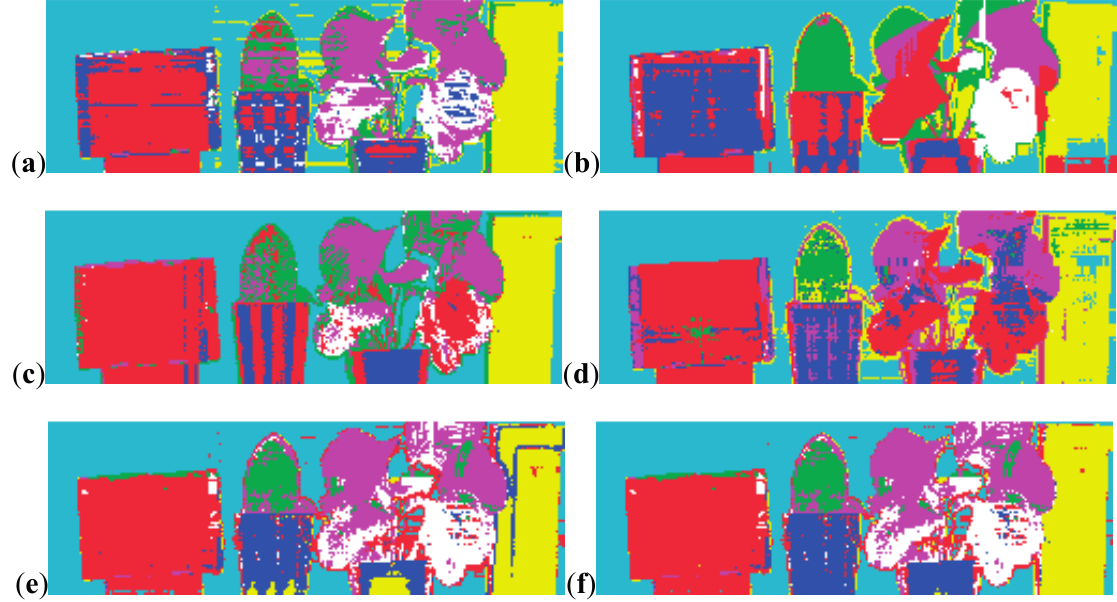
Figure 5. ( a ) Three-dimensional distribution of the scanned points in the scene; ( b ) Interpolated gray image with pixel values representing the distance information; ( c – f ) Interpolated gray images with pixel values representing the reflectance in 556, 670, 700 and 780 nm, respectively.